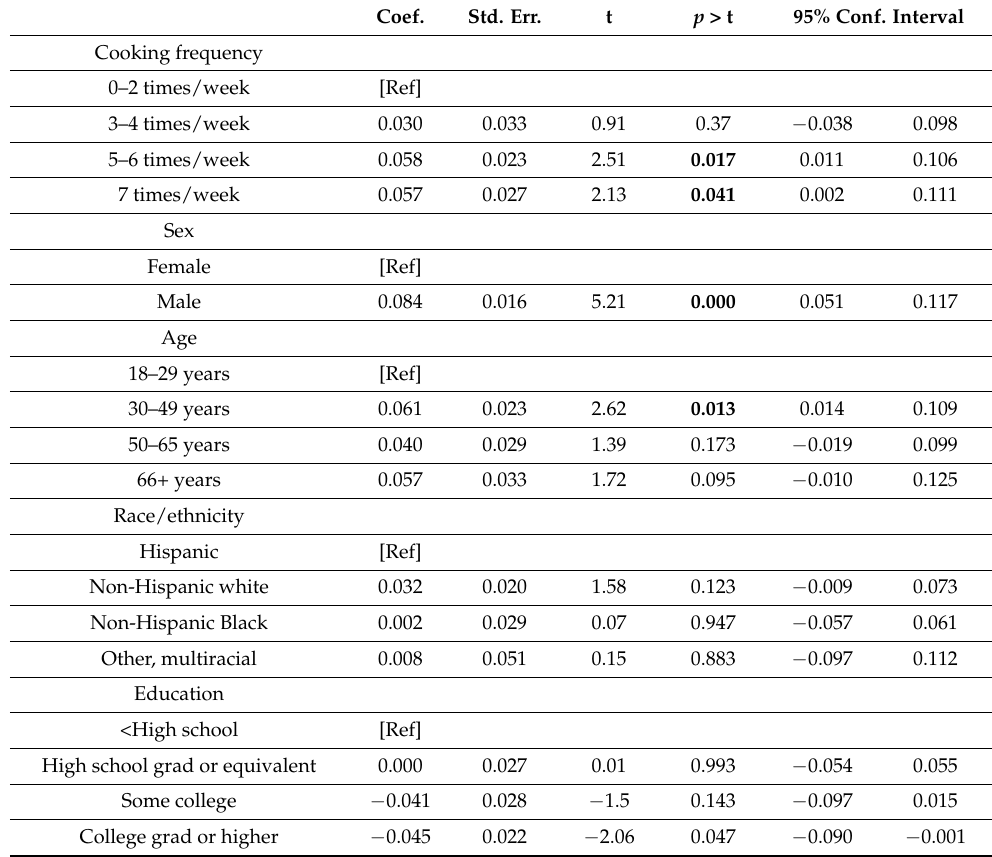
Table A1. Full Model Results for Daily GHGE Per 2000 Kcal by Cooking Frequency, NHANES